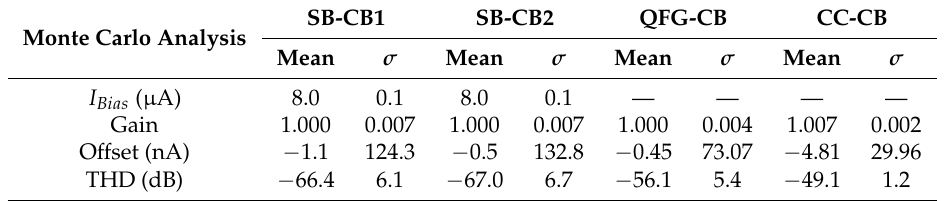
Table 4. Monte Carlo analysis